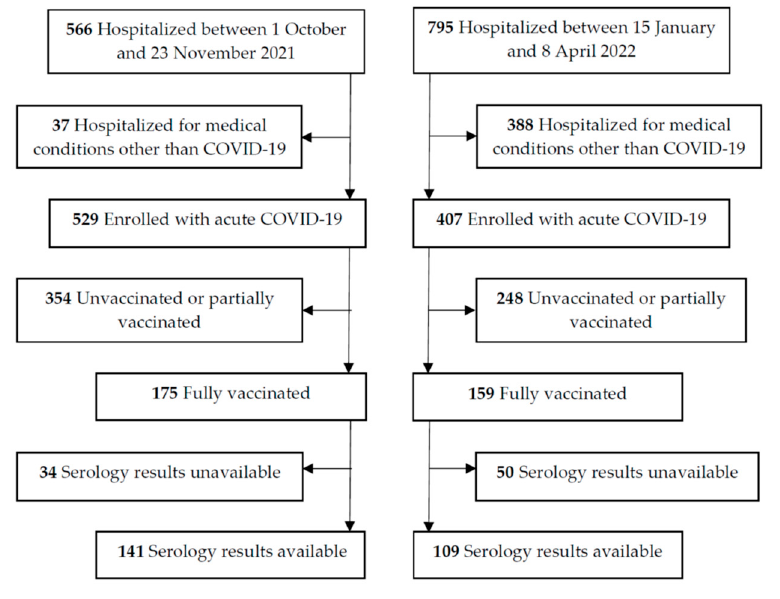
Figure 1. Flow diagram. Table 1. Characteristics of patients hospitalized for COVID-19 by study